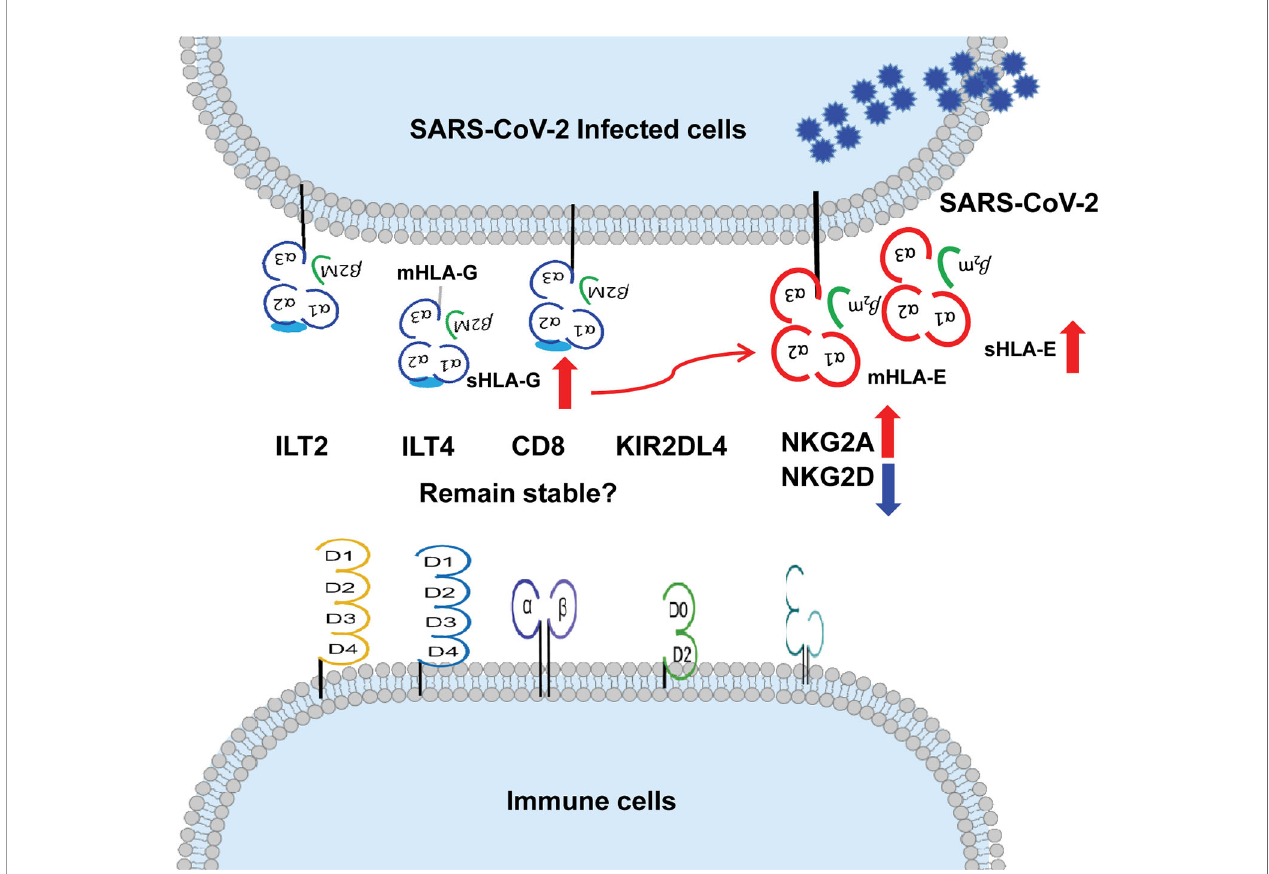
FIGURE 2 | More evidence can be expected on the relationship between up-regulation of HLA-G and HLA-E expression and their immune receptors on immune cells during SARS-CoV-2 infection. ↑ up-regulation. ↓